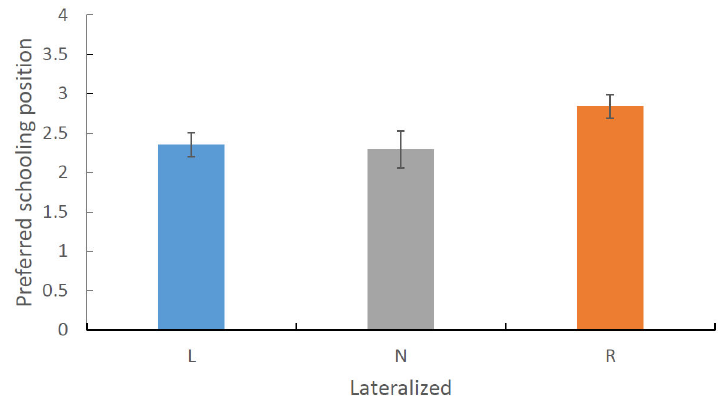
Figure 5. The mean (±SE) preferred schooling position for strongly left, non and strongly right lateralized rainbowfish. Scores greater than 2.5 represent a preference for the left side of the